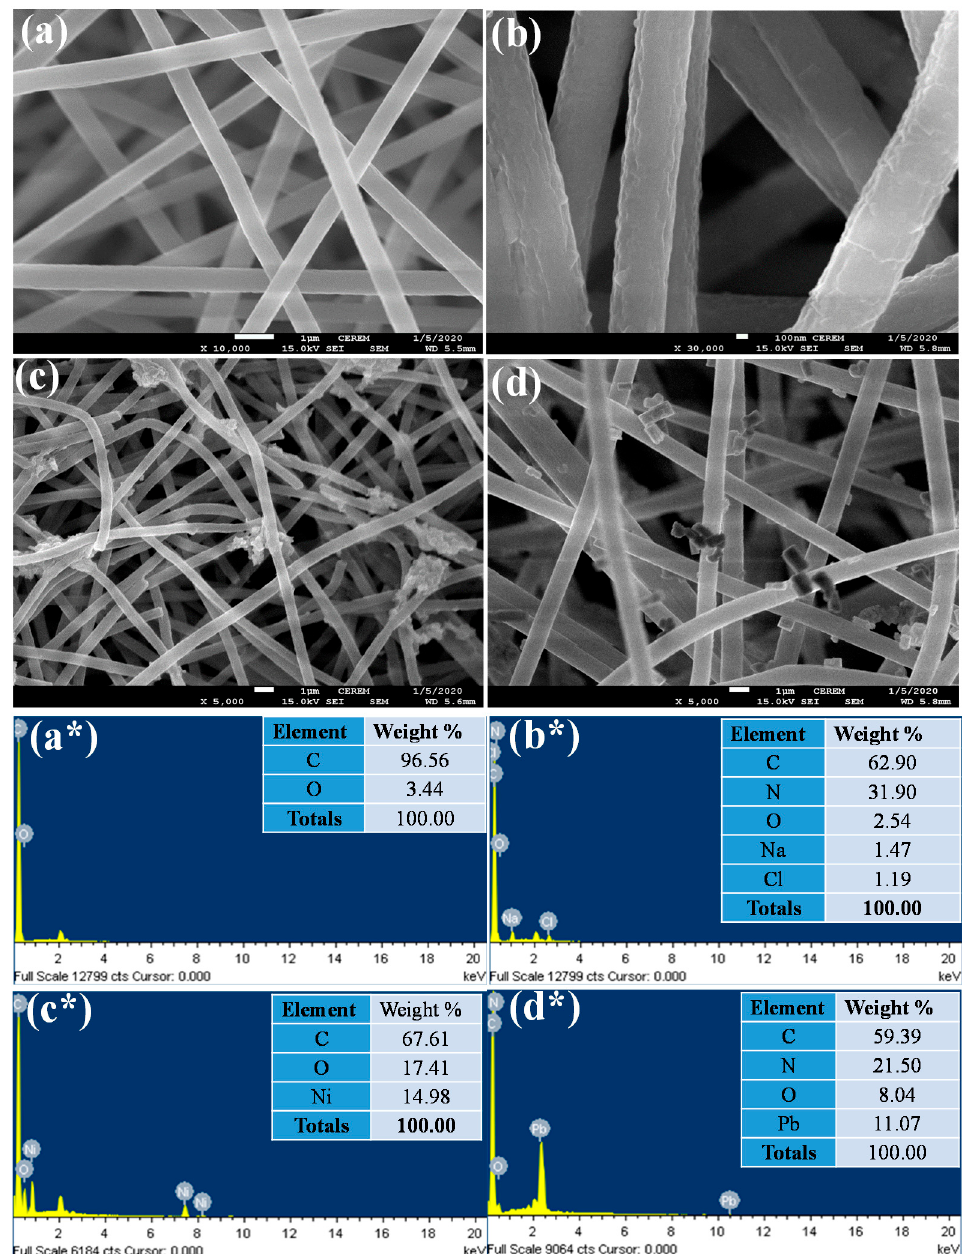
Figure 2. Field emission scanning electron microscopy (FE ‐ SEM) and energy dispersive X ‐ ray spectroscopy (EDX) spectra of PAN nanofibers ( a , a* ), PANmod ( b , b* ), PANmod ‐ Ni 2+ ( c , c* ), and PANmod ‐ Pb 2+ ( d , d* ).